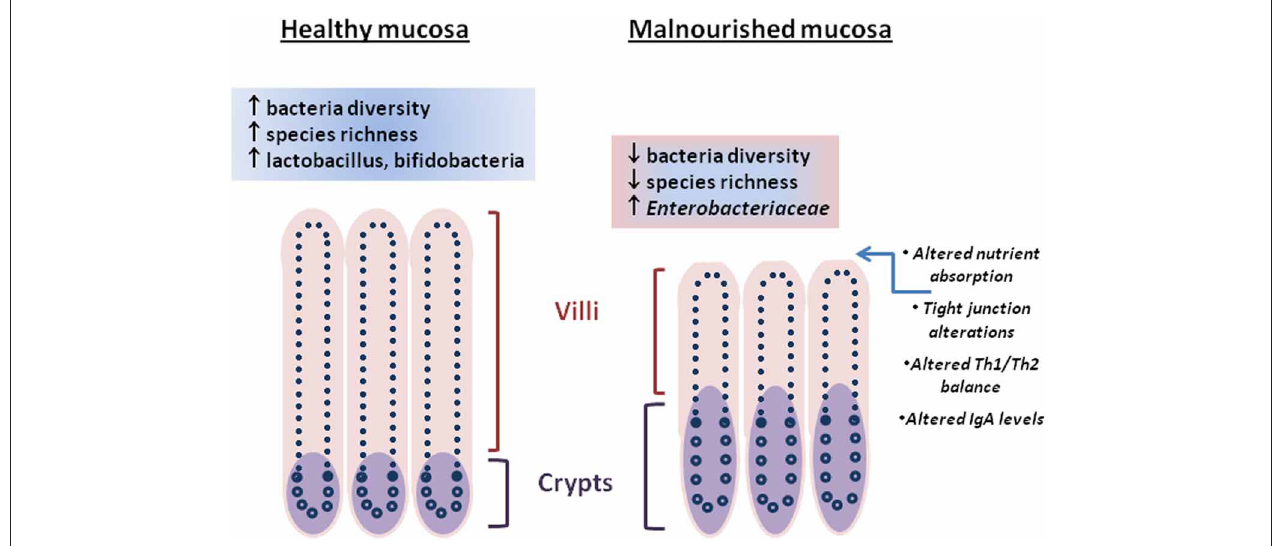
FIGURE 1 | Differences between “healthy” and malnourished intestinal mucosa are represented by architectural changes (villi height/crypt depth, crypt hypertrophy), molecular changes (tight junction alteration,